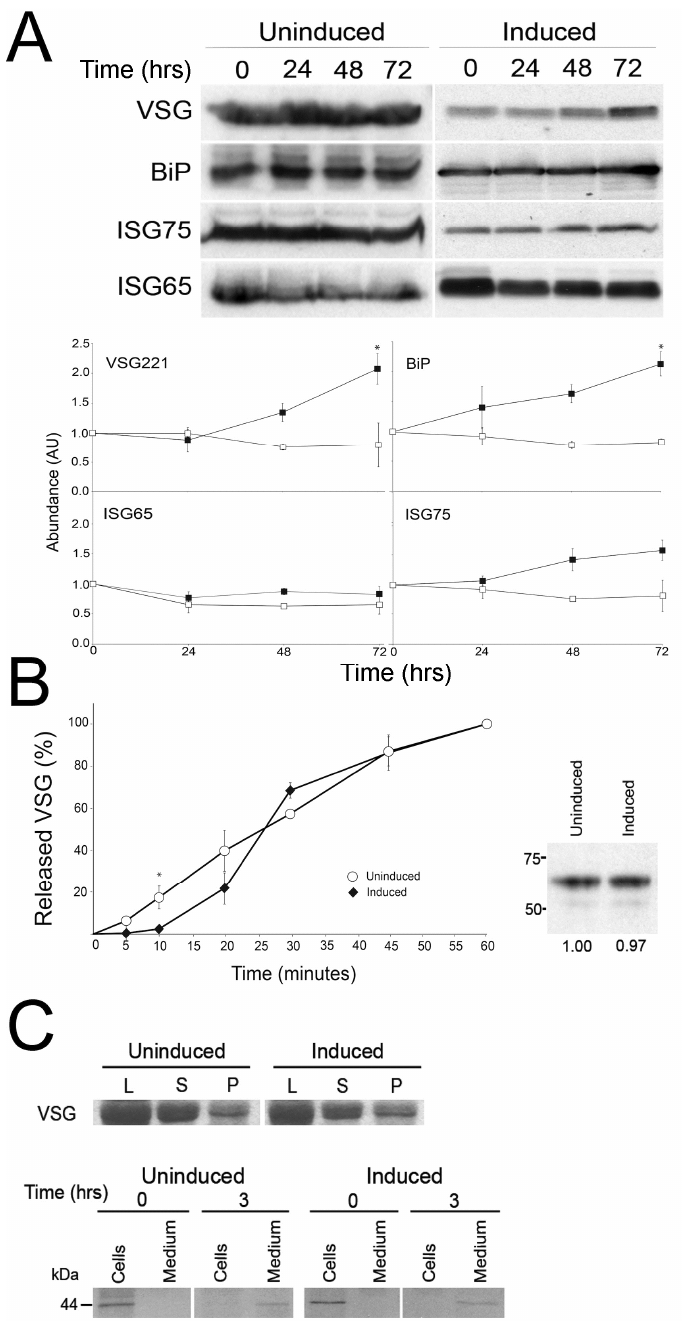
FIGURE 9: Effects of IGP knockdown on major surface protein copy number and exocytosis. (A) Cells were sampled from either induced or uninduced IGP48 RNAi cell lines at the times indicated. Membranes were probed with anti-VSG221, TbBiP, ISG65, or ISG75 and relative protein abundance was determined by densi- tometry. Experiments were done in duplicate and bars indicate standard error of the mean. Data were normal- ised to 100% at t = 0. (B) Export of newly synthesised VSG in induced and uninduced IGP48 RNAi cells. Surface accessible VSG was hydrolysed by GPI-PLC after hypo- tonic lysis of the cells. Soluble and membrane-form VSG was recovered by incubation with ConA-sepharose. Data represent the kinetics of newly synthesised VSG trans- ported from the endomembrane system to the cell sur- face, shown as percent of VSG at the cell surface. Data were taken from two independent experiments and standard error of the mean is shown. Student’s t-test showed statistically significant difference between in- duced and uninduced cells at the time point indicated with an asterisk (p < 0.05). Right panel: Metabolic label- ling of newly synthesised VSG following 24 hour RNAi induction. Newly synthesised VSG was labelled with 35 S- methionine and detected by autoradiography. (C) Top: Hypotonic lysis, followed by separation of surface (su- pernatant, S) and intracellular (pellet, P) VSG 221 was visualised by SDS-PAGE and Commassie staining and levels of VSG compared to that in whole cell lysates (L). No significant difference in VSG distribution is seen be- tween induced and uninduced cells. Lower: Levels of the BiPN reporter following labelling of cells with 35 S- methionine were detected in induced and uninduced cells, following a 3 hour chase. No significant change is seen between export of BiPN from the cell in induced compared to uninduced